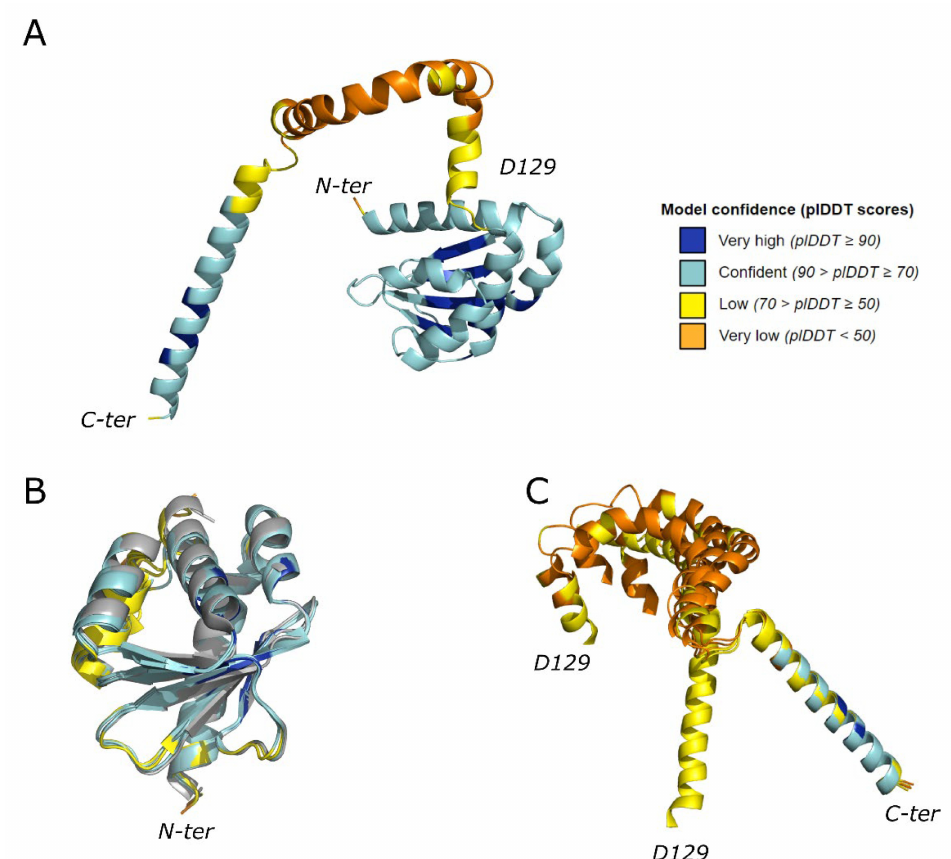
Figure 3. Modelling of UbiJ monomer. ( A ) Best AF2 model of the whole UbiJ represented as a cartoon and is coloured as a function of the pLDDT value. ( B ) Structural comparison of the 5 models of UbiJ SCP2 domain predicted by AF2 and crystallographic structure. The proteins are represented as a coloured cartoon, the X-ray structure in grey (PDB code: 6H6O) and the AF2 models coloured as a function of the pLDDT value. ( C ) Structural differences of the C-ter region of UbiJ (residues 129–201) observed in AF2 models. The structural alignments were performed on the C-ter helices (residues 171–201). The residue numbering corresponds to the Uniprot sequence (Uniprot ID: